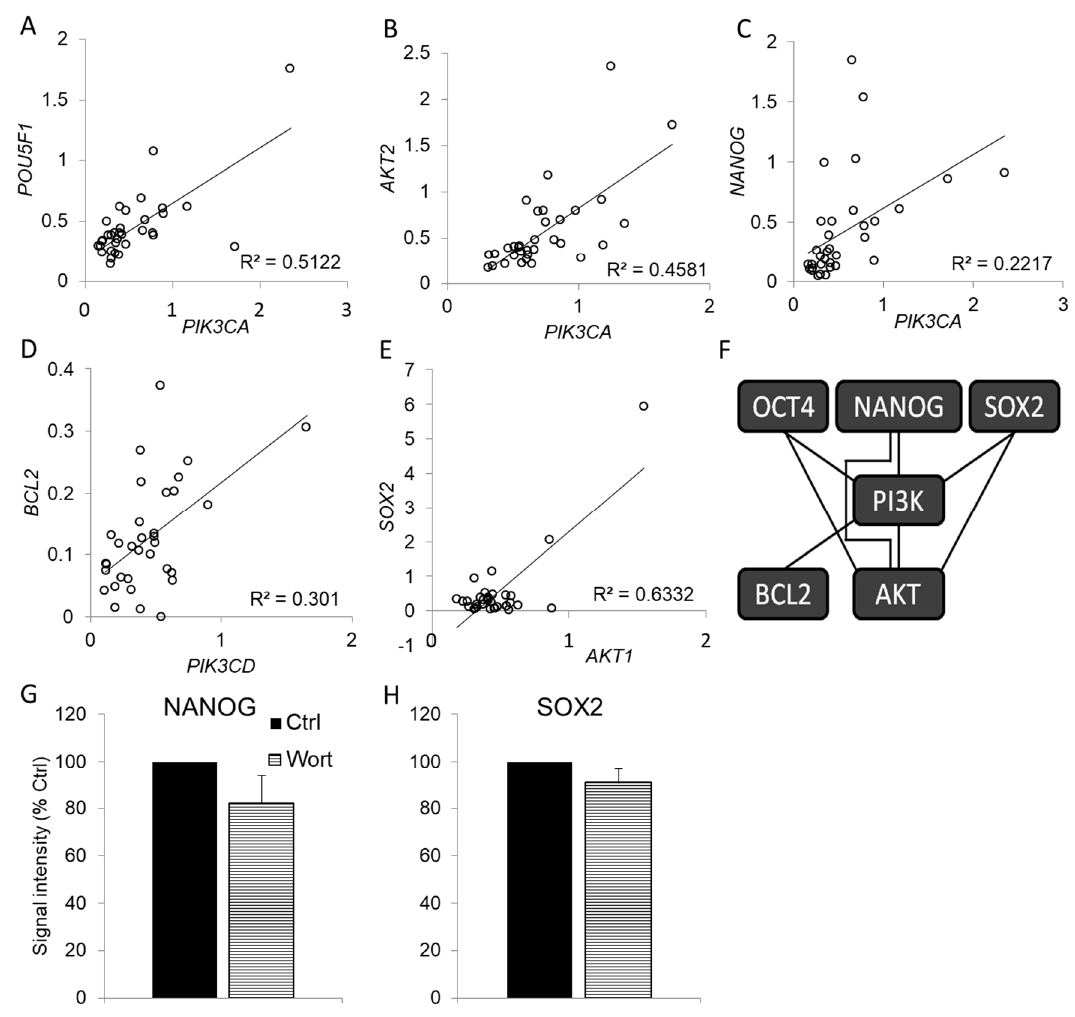
Figure 3. Correlation among expression of genes of pluripotency factors, PI3K-AKT pathway and BCL2 . ( A – E ) Shown are representative correlations among genes expressed in human mesothelioma. ( F ) Genes from Table 1 that exhibit positive correlation of expression are connected in the diagram. ( G and H ). Comparison of the expression of NANOG and SOX2 proteins by immunohistochemical quantification in control (Ctrl, n = 8) and Mero-14 cells treated with 10 µM wortmannin (Wort, n = 8).